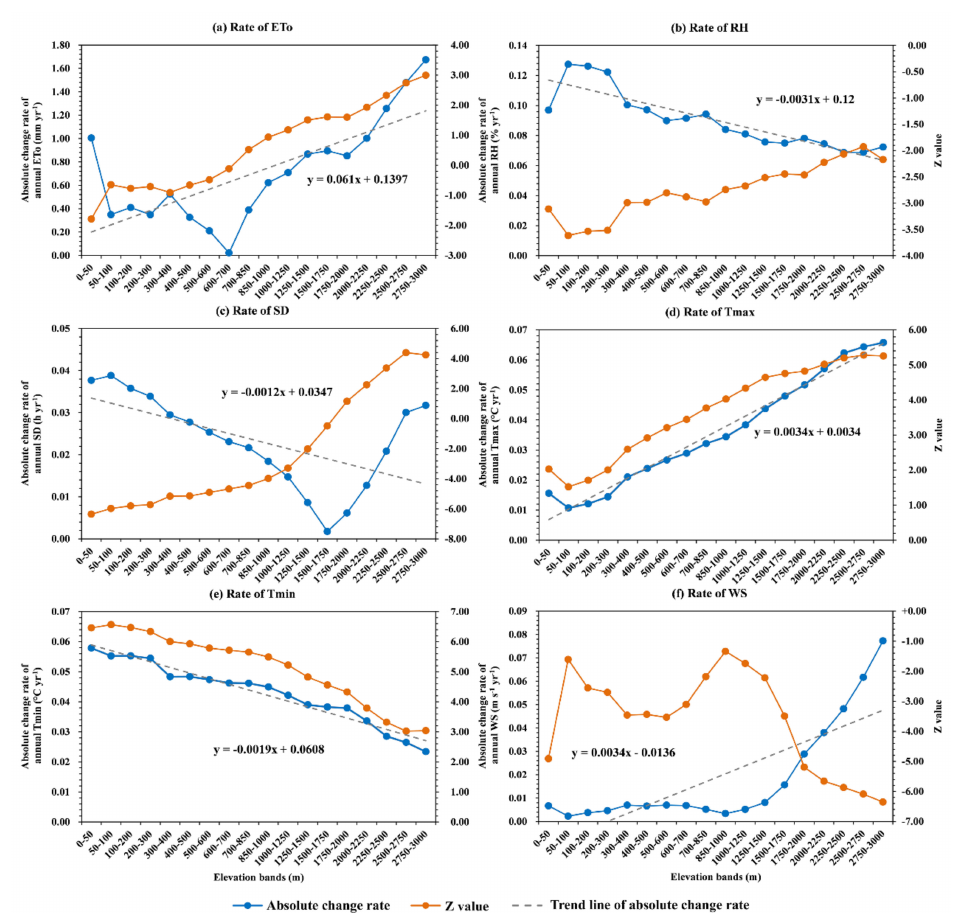
Figure 5. Variations in change rate of ETo ( a ) and each climatic factor ( b – f ) along elevation (i.e., at 18 elevation bands) in THM. The mean absolute change rate (blue line) and Z value (yellow line) at each elevation band are shown. Trend lines of best fit are presented by gray dashed lines, with equations of fit provided on each plot.